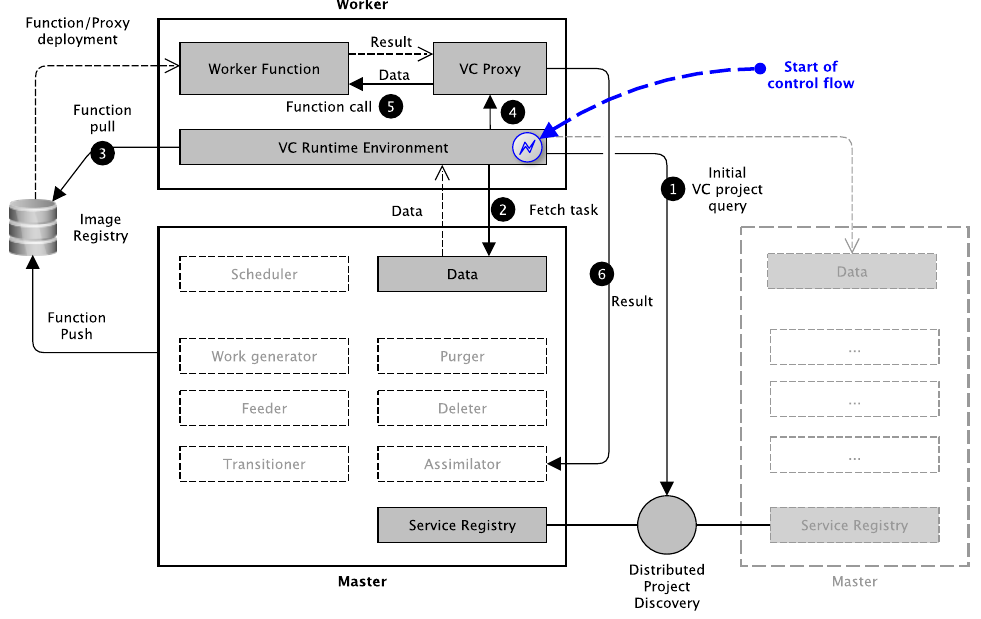
Figure 10. Proposal of an evolved and container-based VC master worker architecture